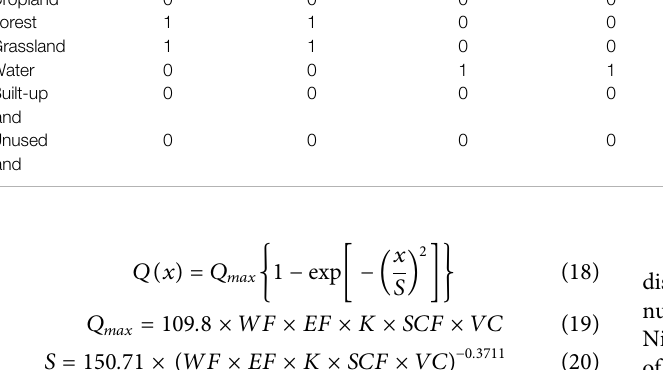
TABLE 4 | Potential activities in each land use type in the CBYN. Horseback